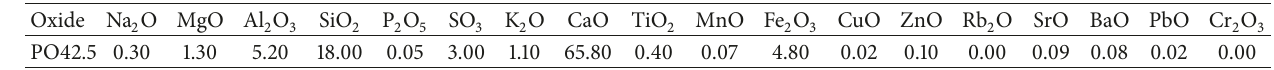
Table 1: Oxide composition of Portland cement used in this study ∗ .